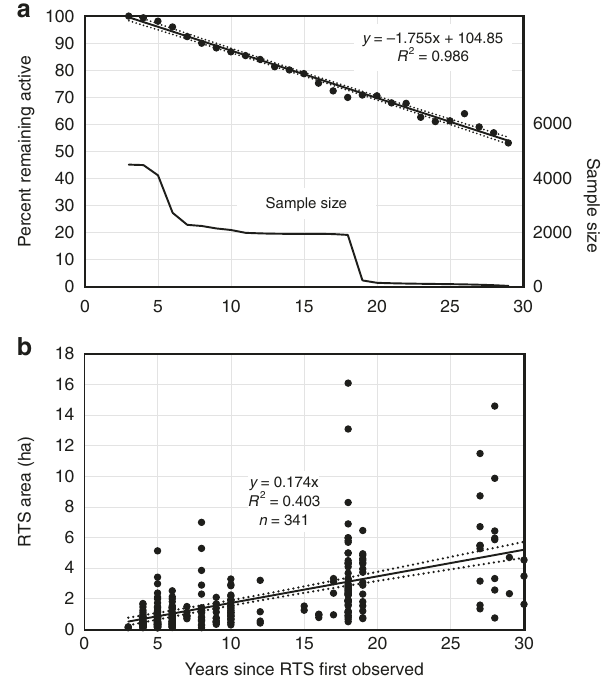
Fig. 3 Longevity and growth of retrogressive thaw slumps. a Percent of all observed features remaining active for a given duration. Best- fi t relation is for retrogressive thaw slumps >2 years old and for sample size >30 (upper solid line). Dotted lines are 95% con fi dence intervals. Lower solid line is sample size. All retrogressive thaw slumps were active for at least 3 years. b Measured area of sampled active retrogressive thaw slumps against age. Best- fi t line was constrained through the origin. Dotted lines are 95% con fi dence intervals